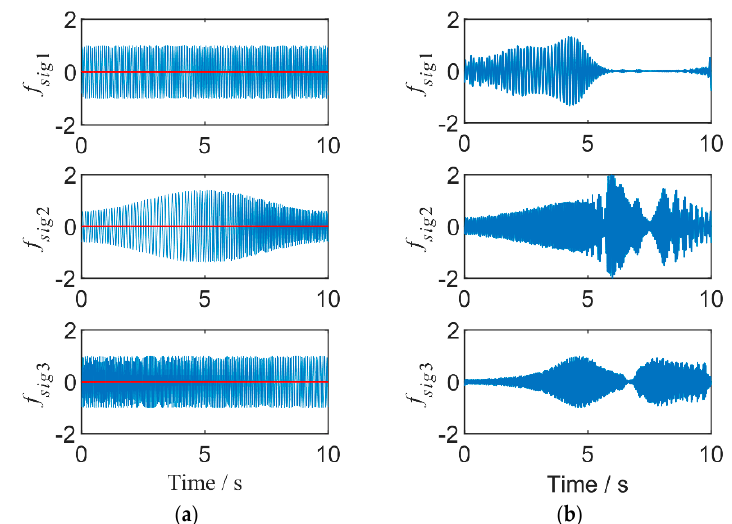
Figure 3. Analysis results. ( a ) The estimated modes by VSME (blue: estimated modes; red: estimation errors). ( b ) The estimated modes by VMD.